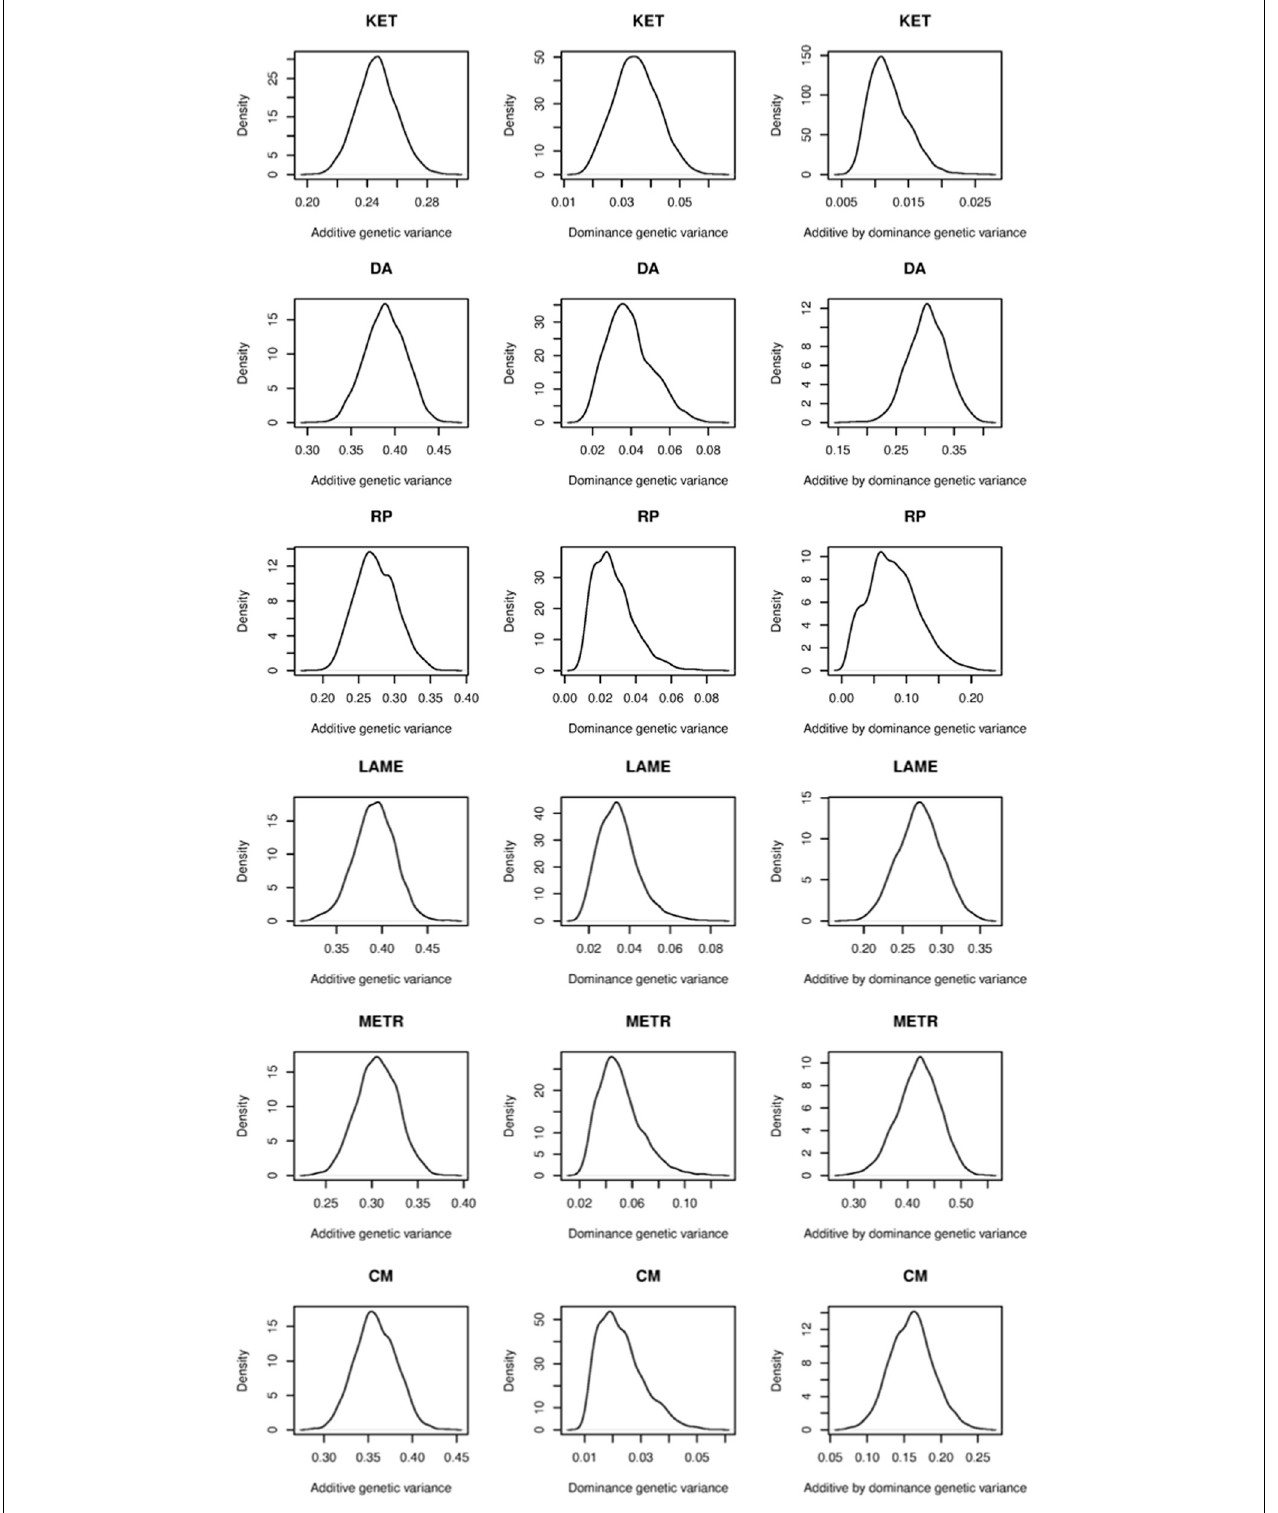
FIGURE 4 | Posterior density plots of the ratios of variance components for ketosis (KET), displaced abomasum (DA), retained placenta (RP), lameness (LAME), metritis (METR), and clinical mastitis (CM). Estimated breeding value was used as phenotype.